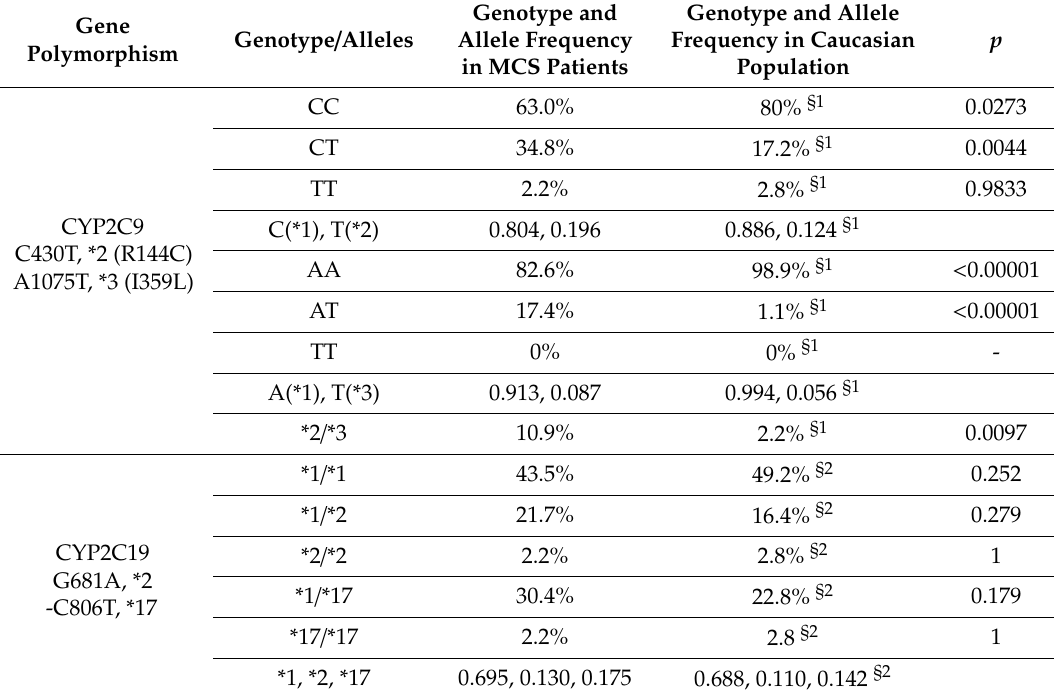
Table 2. Distribution of gene polymorphisms of enzymes involved in xenobiotic metabolism, oxidative stress, and DNA methylation / repair